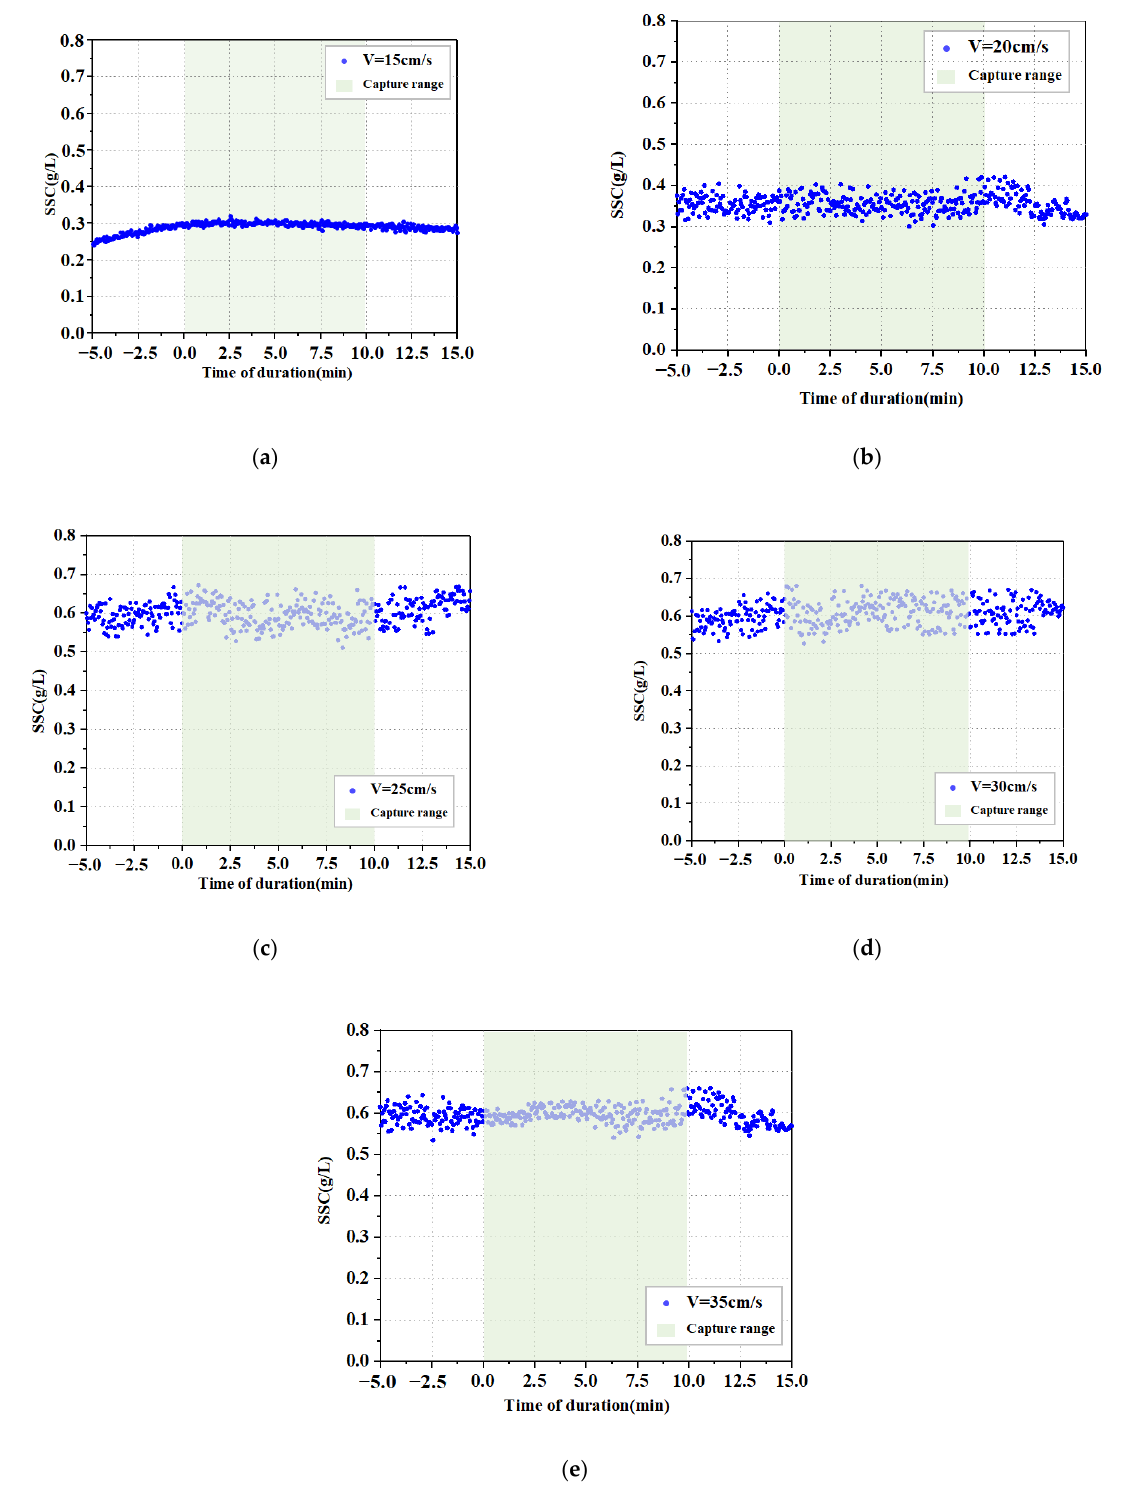
Figure 10. Variation of suspended sand concentration at each flow rate: ( a ) 15 cm/s; ( b ) 20 cm/s; ( c ) 25 cm/s; ( d ) 30 cm/s; ( e ) 35 cm/s.